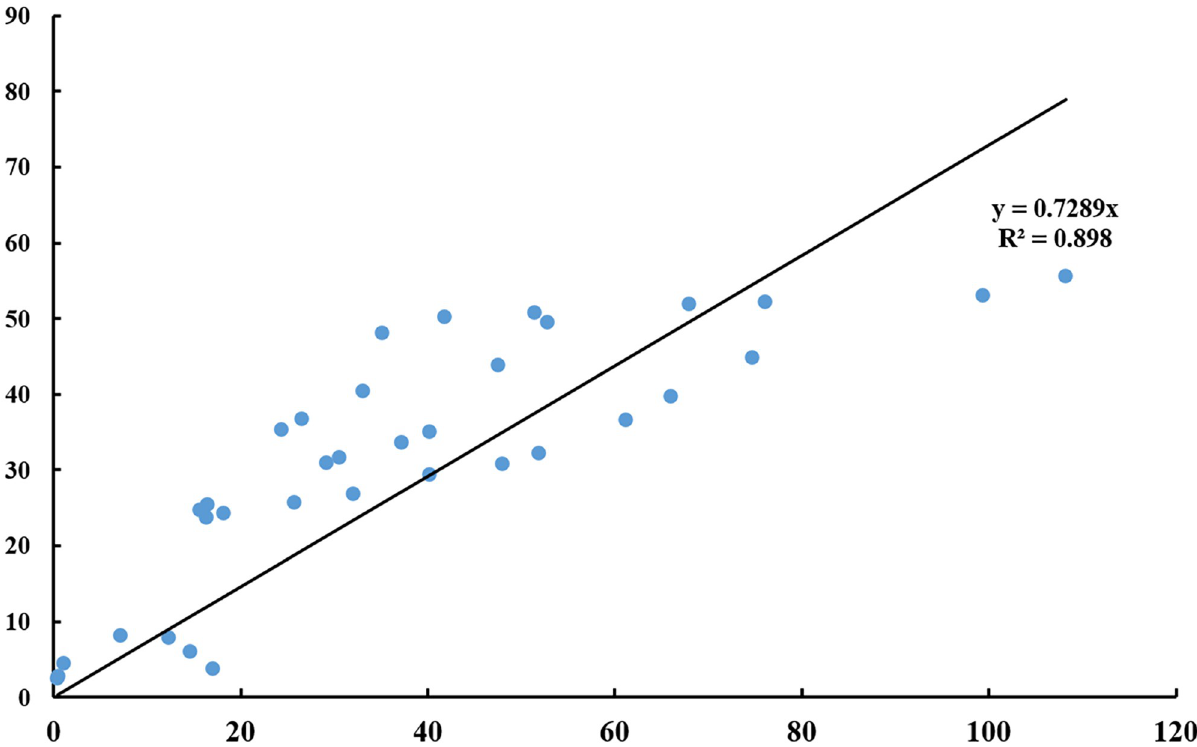
Fig 5. Infinite-sites plot. The plot shows the estimated posterior mean times versus the estimated posterior confidence interval (CI) widths.